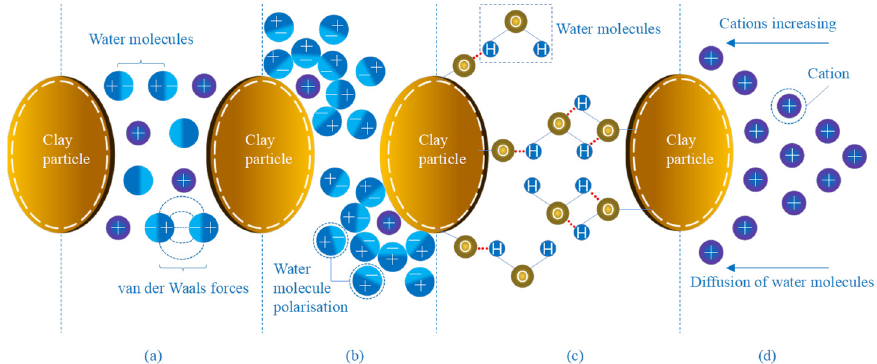
Figure 10. Interaction forces between clay particles and water (reproduced with permission from from Li., Advanced Soil Mechanics; 2nd ed.; published by Tsinghua University Press: Beijing, China, 2016. [37], and Liu et al., published by Geotechnics and Soil Mechanics; published by Science Press: Beijing, China, 2009 [38]).